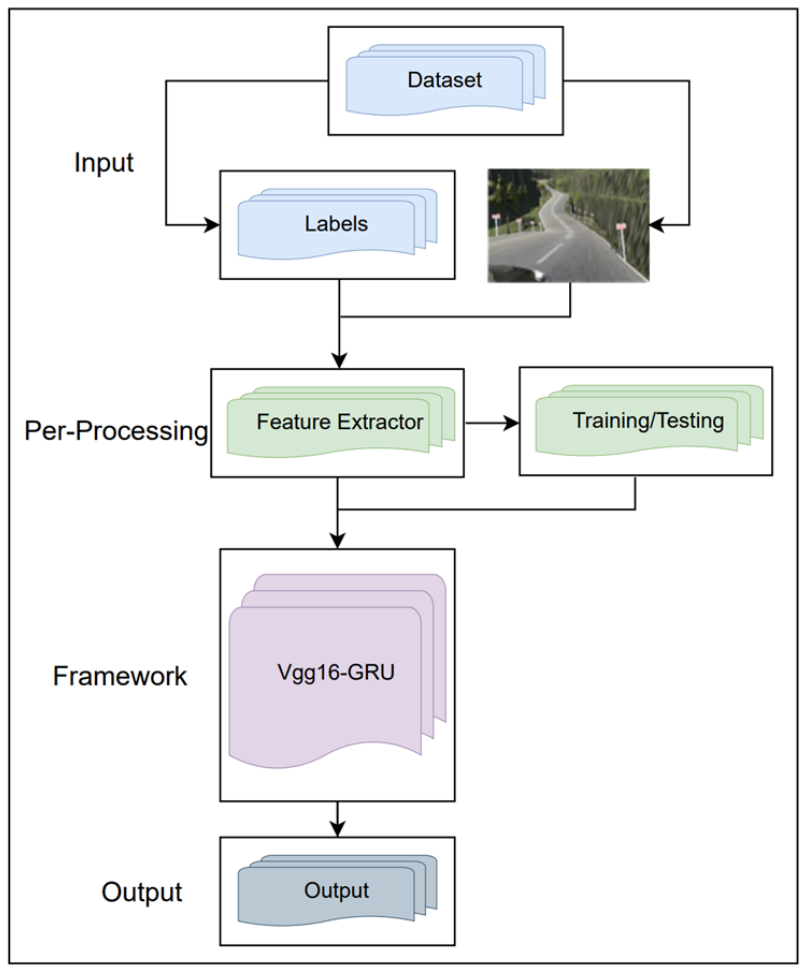
Figure 2. Overview of the proposed